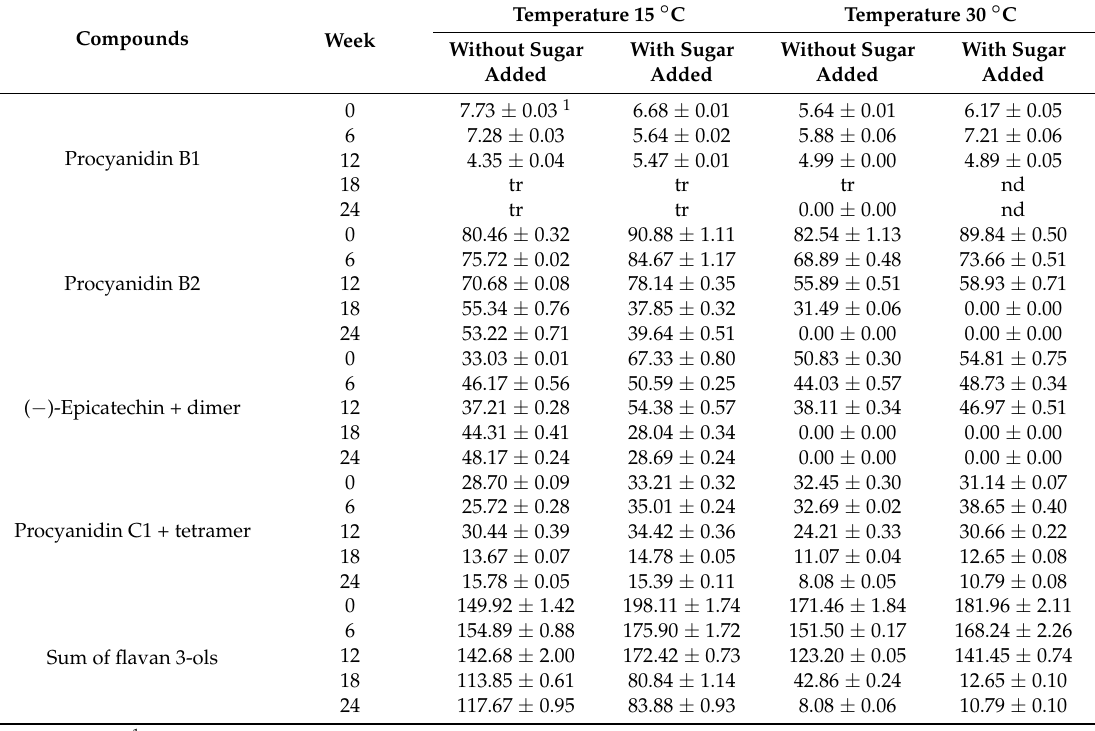
Table 2. Changes in flavanols content ( µ g/mL) during cherry liqueurs